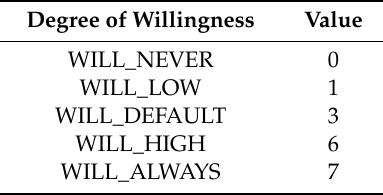
Figure 1. HELLO message packet format in an OLSR network [8]. Table 2. Willingness and its values [8].